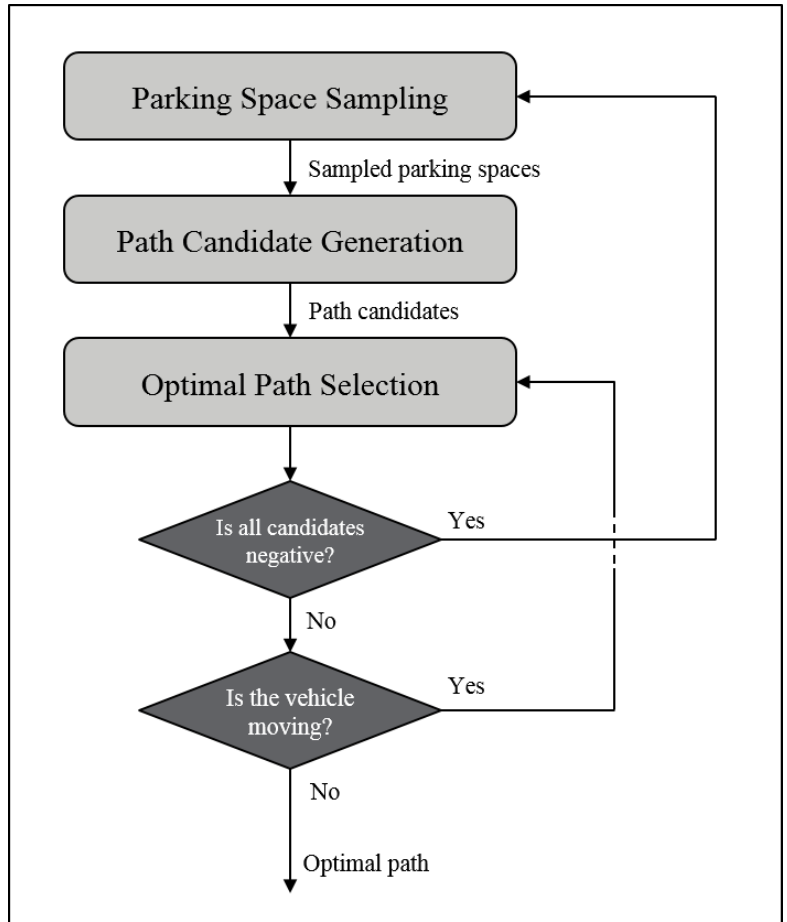
Figure 9. Flow diagram of the overall re-planning